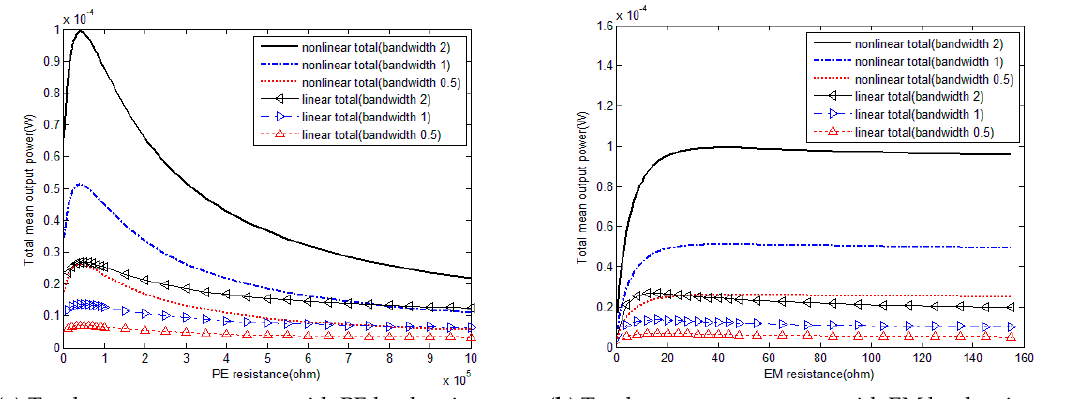
Figure 9. Mean output power of hybrid energy harvester with different excitation bandwidths.